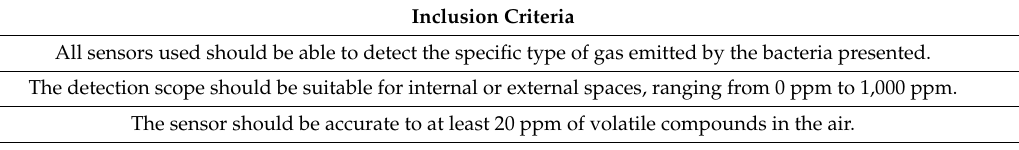
Table 1. Inclusion criteria of the sensors